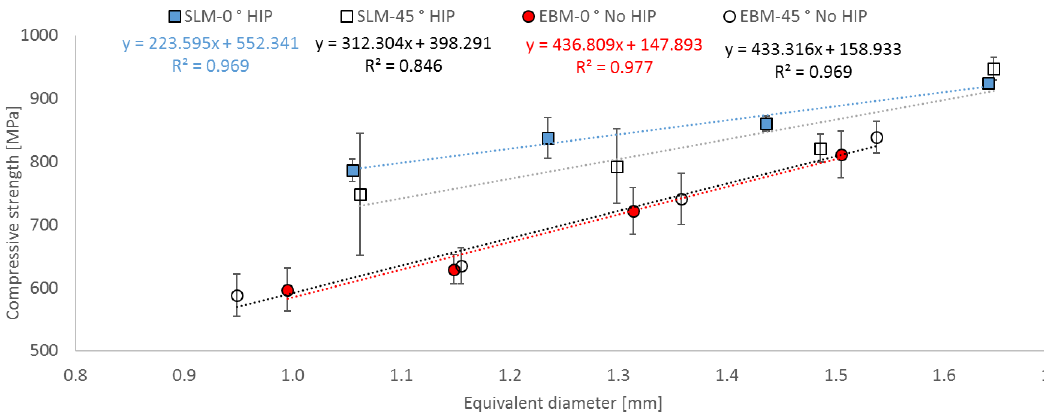
Figure 16. Relation between equivalent diameter and compressive strength for SLM parts (HIP) and EBM parts (No HIP) in the orientations 0° and 45°.